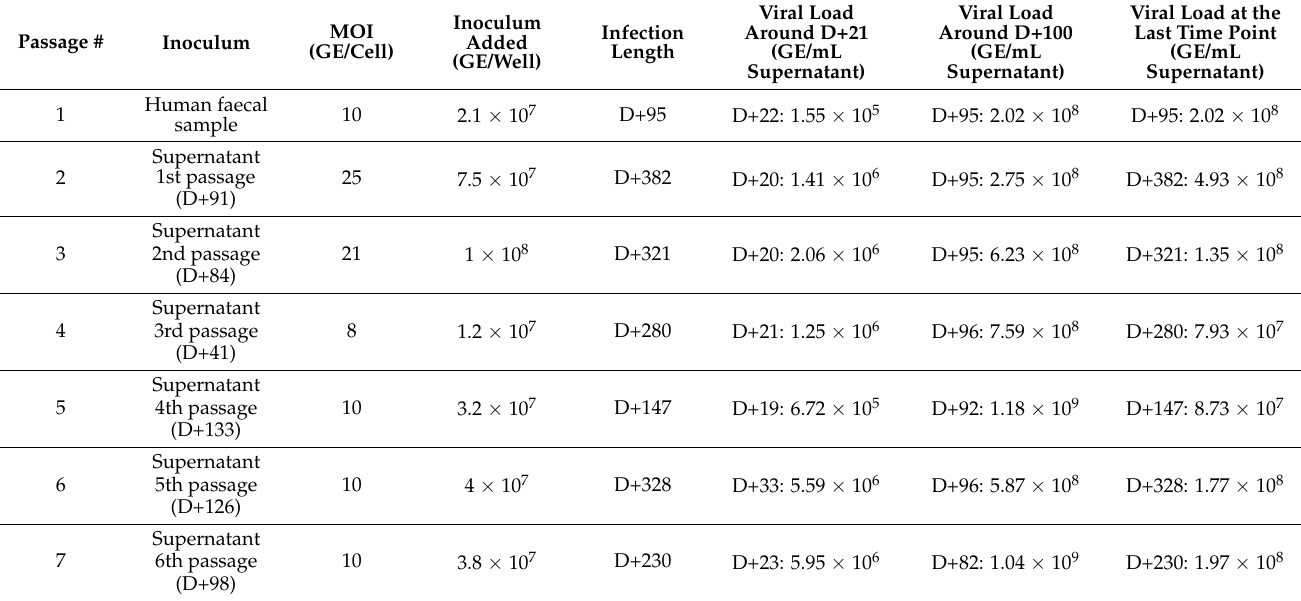
Table 1. Consecutive passages of HEV in HepaRG cells. The origin of the inoculum, the estimated multiplicity of infection (MOI) used as well as the length of infection are indicated for each passage. D =